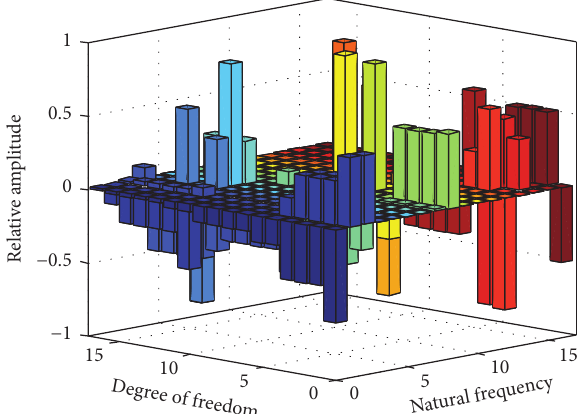
Figure 10: Vibration modes of planetary reducer.